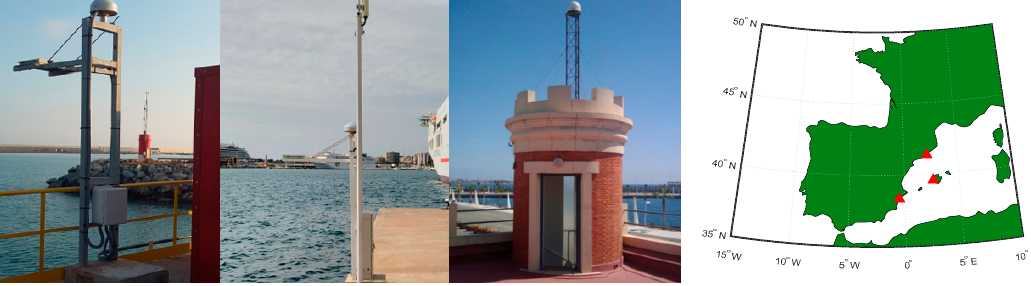
Figure 1. BCL1, MAL1 and ALAC GNSS antennas. General location map (right).